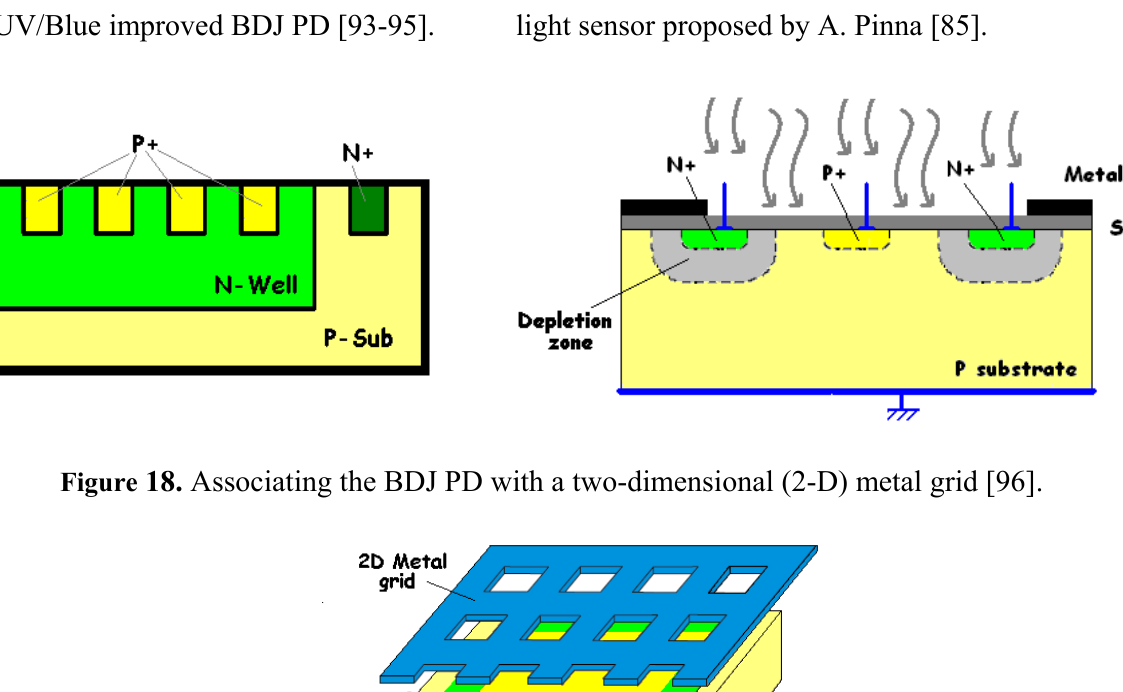
Figure 17. Simplified cross-section of the large-band light sensor proposed by A. Pinna [85].